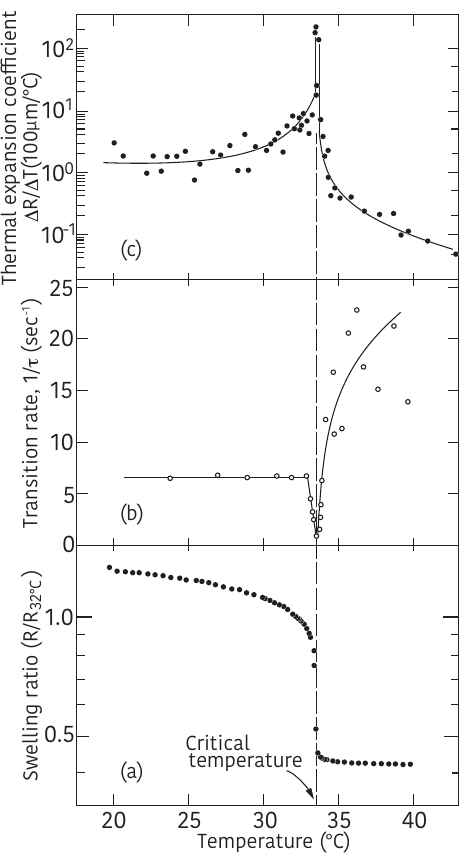
Figure 9. Critical kinetics of the gel. The swelling curve of the gel ( a ); the temperature dependence of the transition rate of the volume change ( b ); and the temperature dependence of the thermal expansion coefficient of the gel ( c ). Reproduced with permission from Ref. [8]. © 1986, The Physical Society of